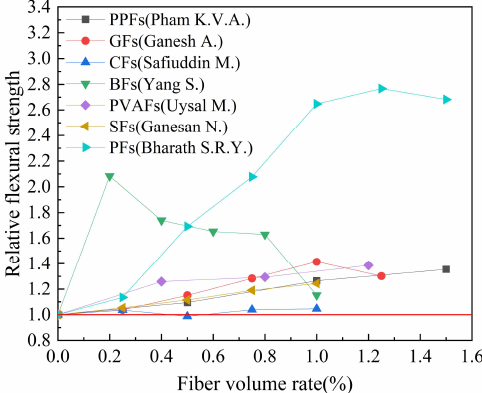
Figure 21. The effect of fiber type on flexural strength.